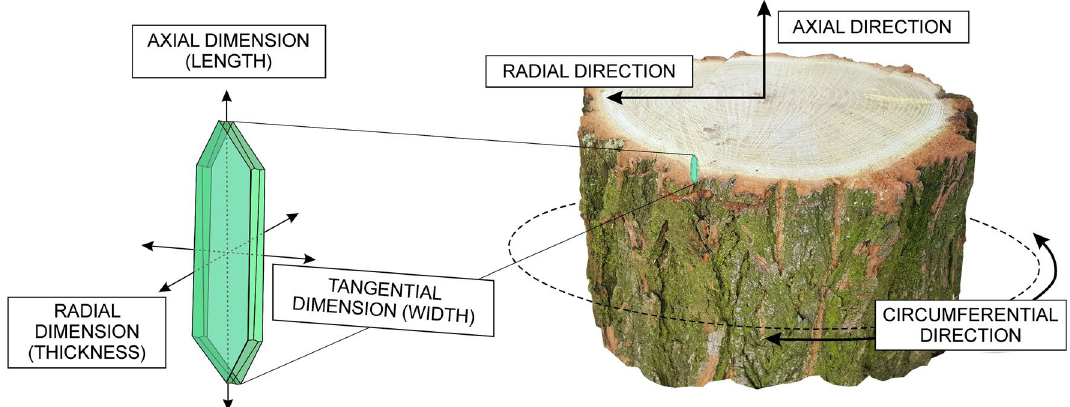
Figure 1. Scheme showing three main directions of cell growth in cylindrical vascular cambium (right), and description of the cell dimensions (left). Descriptions of the cell dimensions illustrate contextual link to the corresponding directions within the tree trunk with cylindrically shaped vascular cambium. Adobe Photoshop CS6 Extended ver.13.0 × 64 (https:// www. adobe. com), and CorelDRAW Graphics Suite SE ver. 18.2.0.840 (https:// www. corel draw. com) were